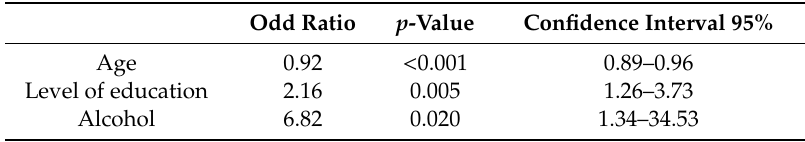
Table 5. Model of logistic